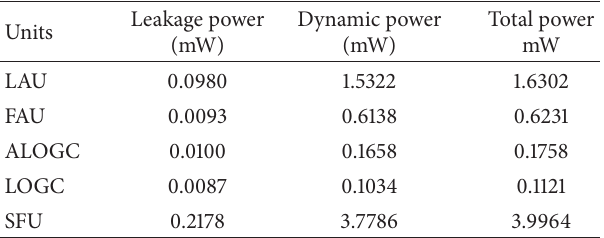
Table 8: Report of the power consumed by each unit.